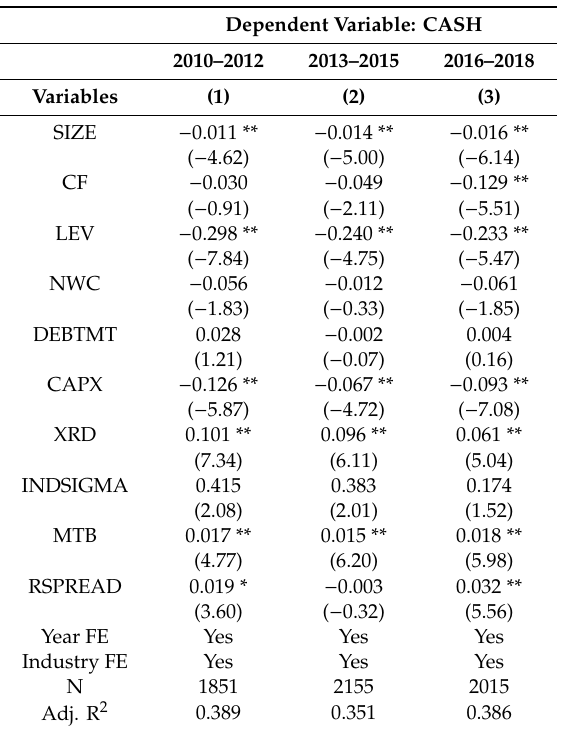
Table 11. Determinants of cash holdings in alternative